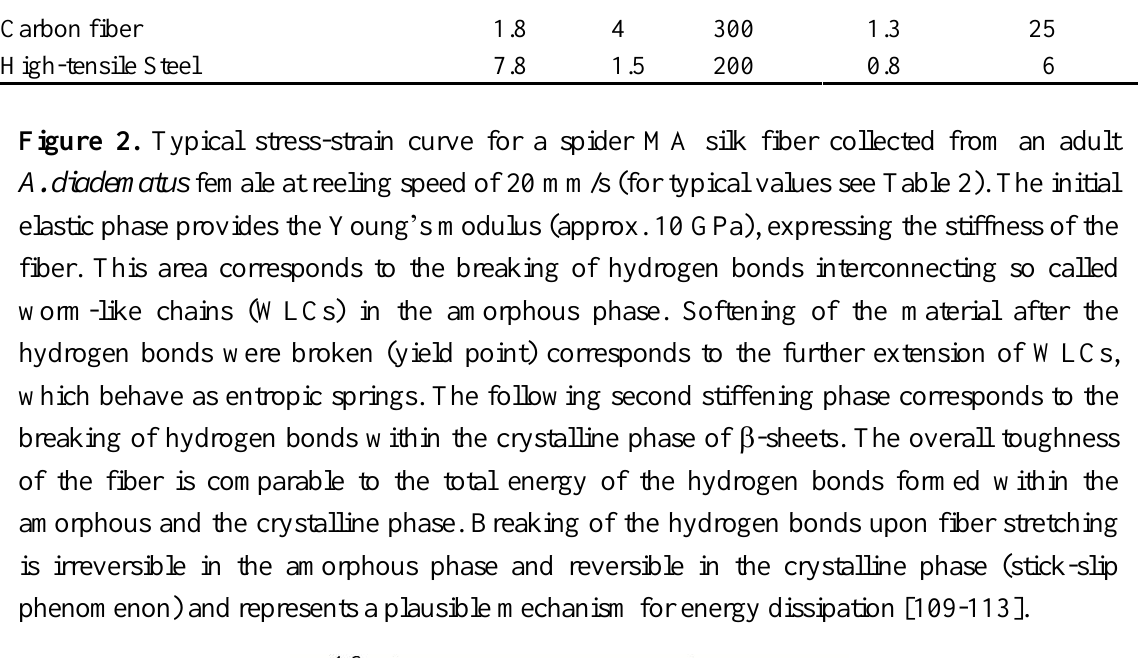
Figure 2. Typical stress-strain curve for a spider MA silk fiber collected from an adult A. diadematus female at reeling speed of 20 mm/s (for typical values see Table 2). The initial elastic phase provides the Young‘s modulus (approx. 10 GPa), expressing the stiffness of